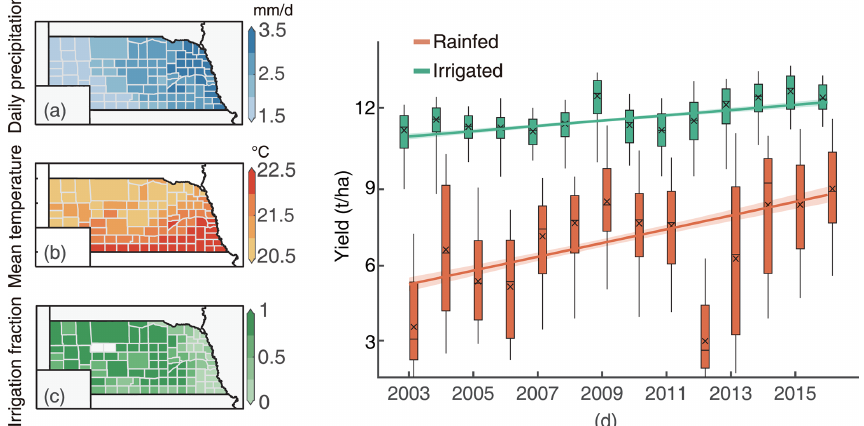
Figure 1. The spatial pattern of county-level multi-year (2003–2016) mean daily precipitation (a) and air temperature (b) during the maize growing season. County-level multi-year (2003–2016) mean maize irrigation fraction across Nebraska (c) . The maize irrigation fraction is based on the USDA NASS report. Box plot of county-level irrigated and rainfed maize yield in Nebraska over the study period (d) . The lines in (d) show the linear fitted yield trend with a 95% confidence interval. Box plots indicate the median (horizontal line), mean (cross), interquartile range (box), and 5th–95th percentile (whiskers) of rainfed or irrigated yield across all